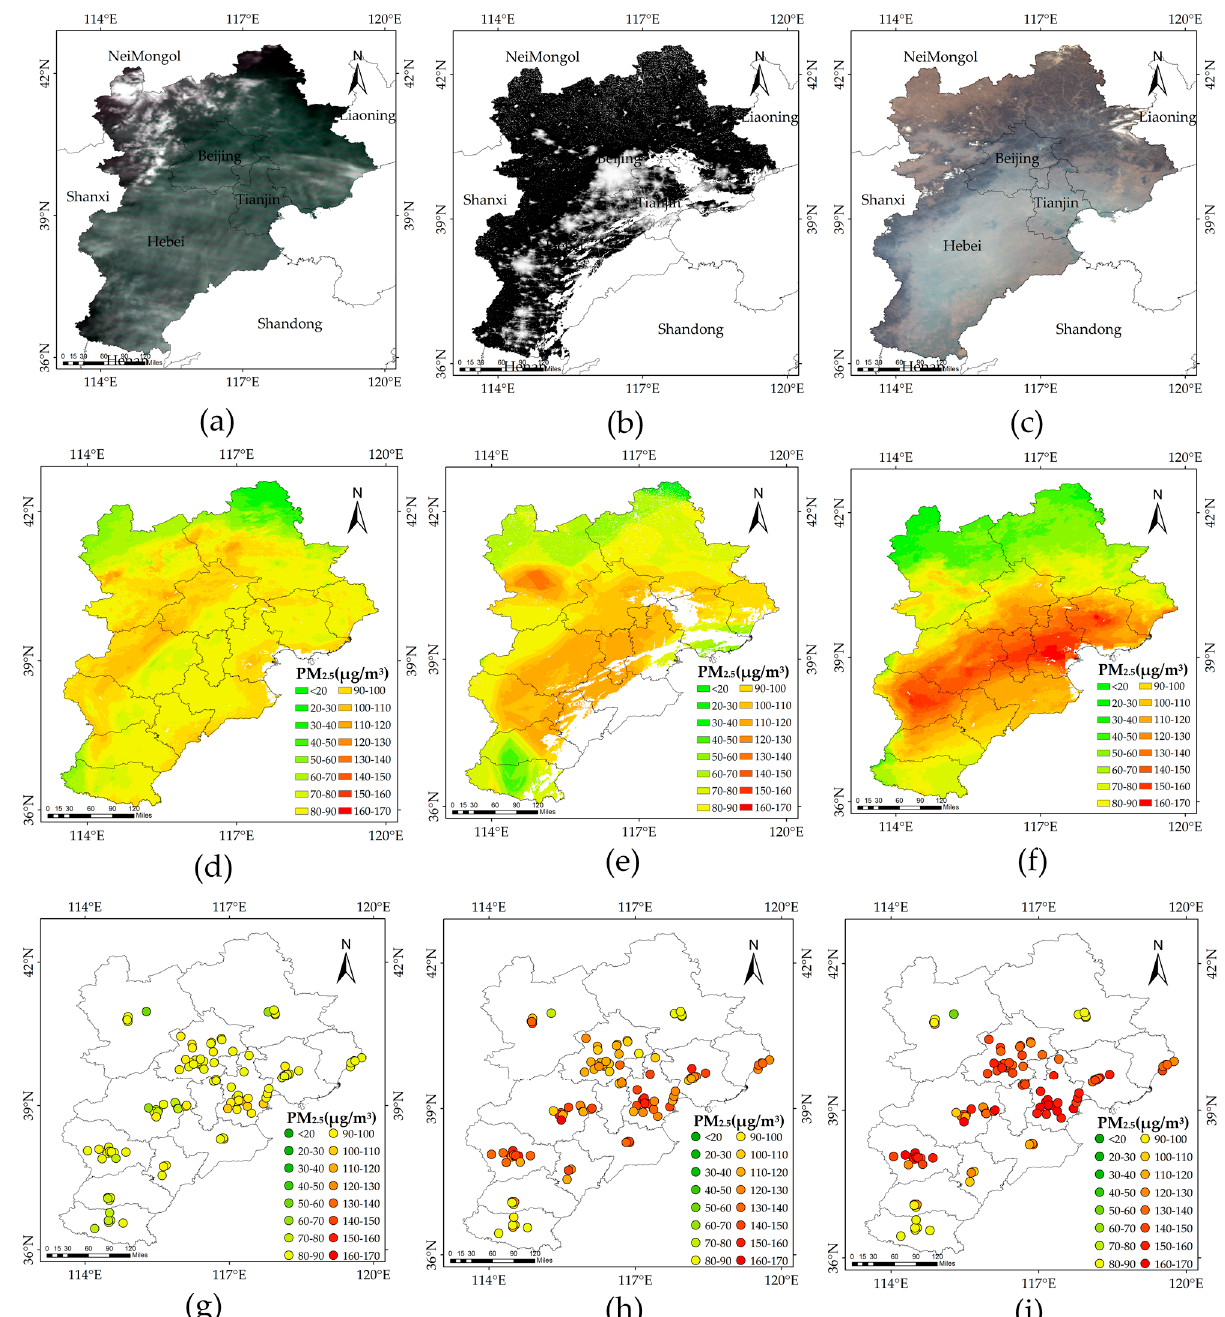
Figure 15. Diurnal variation of pollution in the BTH region based on satellite remote sensing images. ( a ) True color image of MODIS on 8 March 2021 (03:50 UTC); ( b ) Cloud-masked VIIRS/DNB radiance on 8 March 2021 (17:32 UTC); ( c ) True color image of MODIS on 9 March 2021 (02:55 UTC); ( d – f ) Plots of PM 2.5 concentration estimations corresponding to ( a – c ); ( g – i ) Plots of PM 2.5 concentration observations at ground stations corresponding to ( a – c ).